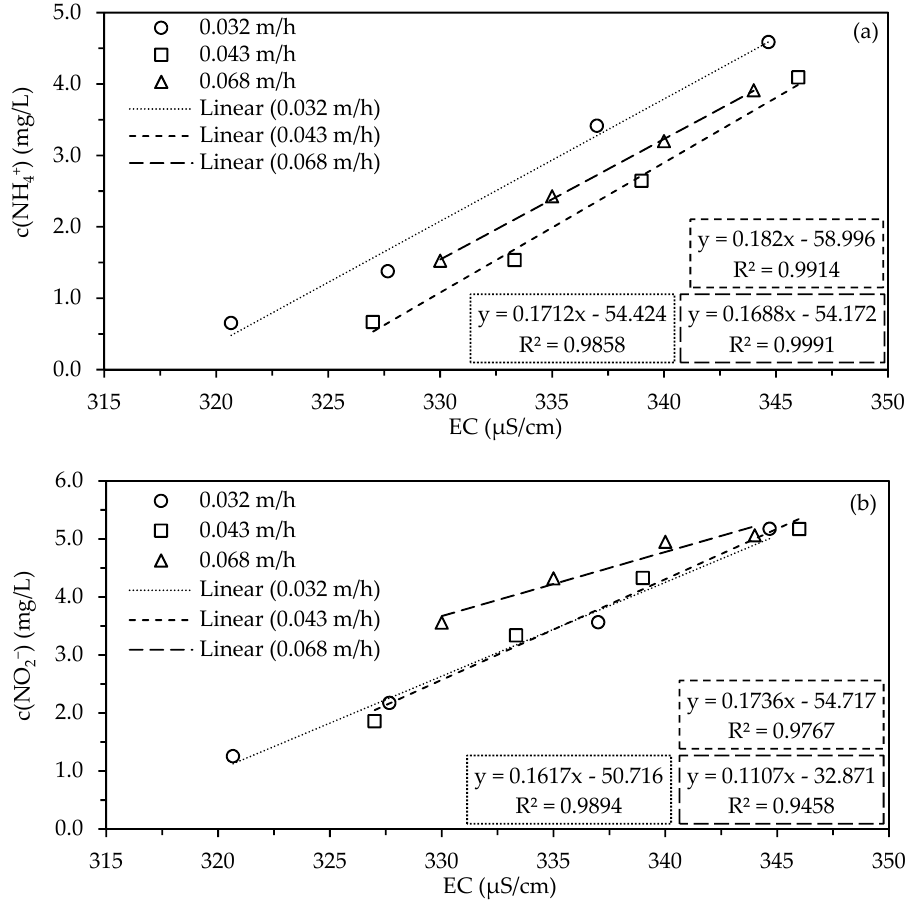
Figure 6. Correlation of NH 4+ ( a ) and NO 2 − ( b ) removal with the electrical conductivity de- pending on the filter velocity (matrix: Elbe-/tap water (1:10); v F = 0.032, 0.043, 0.068 m/h; c 0 (NH 4+ ) = 4.3 mg/L; c 0 (NO 2 − ) = 5.7 mg/L; c 0 (DOC) = 2.5 mg/L; pH: 7.8; T = 22 ◦ C; n =